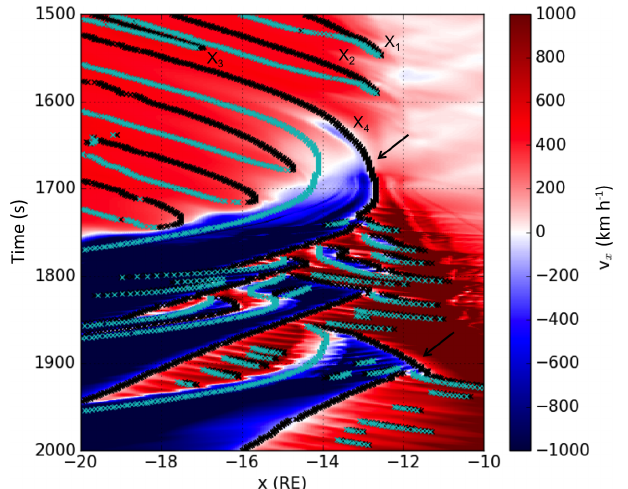
Figure 3. Motion of the X and O points in the tail. The background colour-coding shows the tail V X as a function of time (on y axis, running from top to bottom to ease comparison with Fig. 2) and X location (in x axis) in the central plasma sheet. Individual X points are given as a function of time as black marks, while the magnetic islands are shown as cyan marks. X points X 1 to X 4 are labelled. The building of the two major X lines discussed in this paper are marked with an